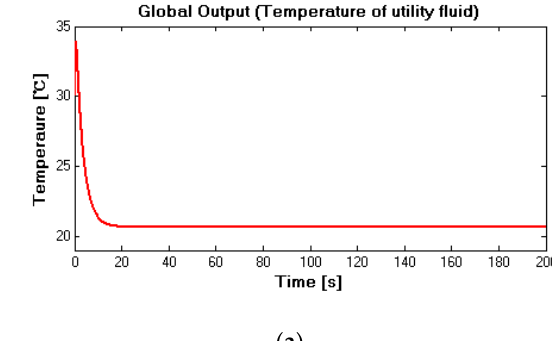
Figure 4. ( a ) Measured (cid:1846) (cid:3009) (noise-free situation) in case 1; ( b ) measured (cid:1846) (cid:3009) (noise-corrupted situa- tion) in case 1.